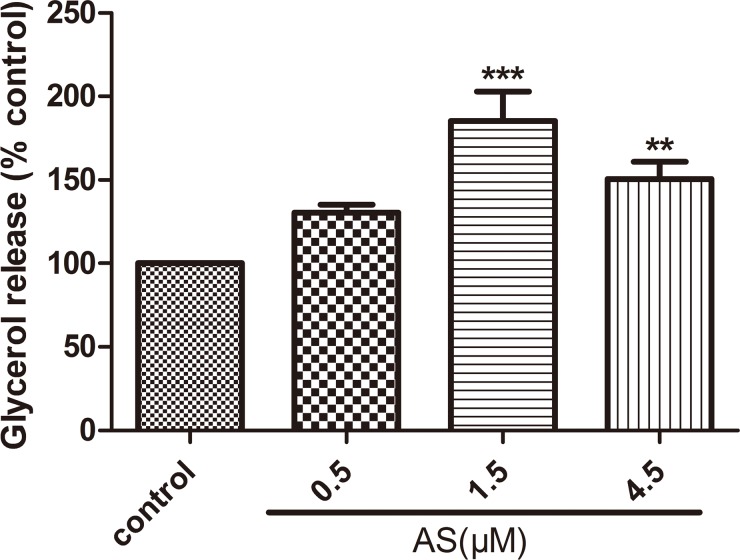
AS induces lipolysis in mature adipocytes.Mature 3T3-L1 cells were incubated with various concentrations of AS (0, 0.5, 1.5, and 4.5 μM) for 24 h. Values are expressed as mean amount (± SE) of glycerol released per well as a percentage of the control value. Four replicates were carried out for each treatment. Means denoted with a different letter are significantly different (P < 0.05).